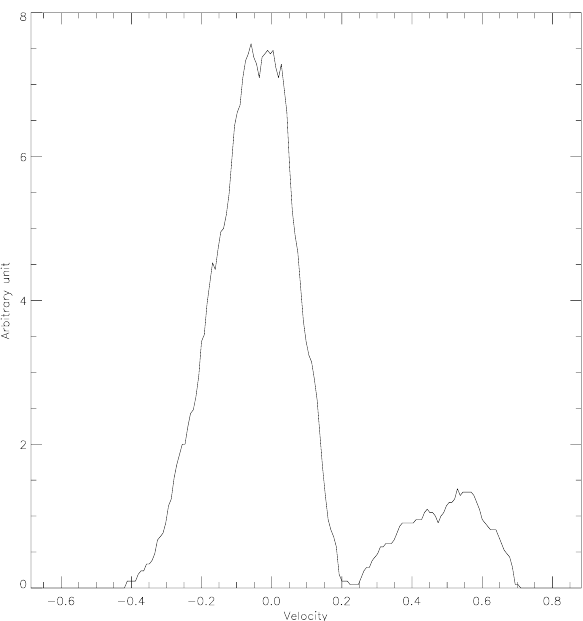
Fig. 6. Electron velocity distribution function leading to the beam- plasma instability at ω pe t = 480 and Z = 188 c/ω pe (between la- bels 2 and 3 on Fig. 2) in the density gradient